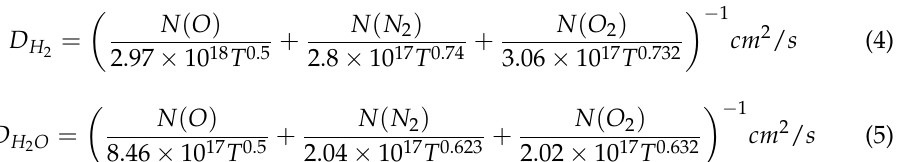
Table 3. The meaning of related parameters in the formula (8).